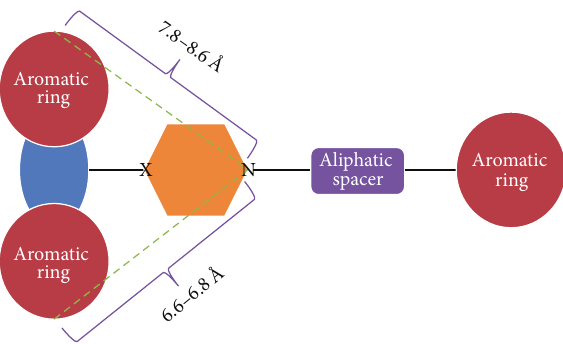
Figure 6: Structural model with detailed generic structural features that may afford potent antipsychotic activity.